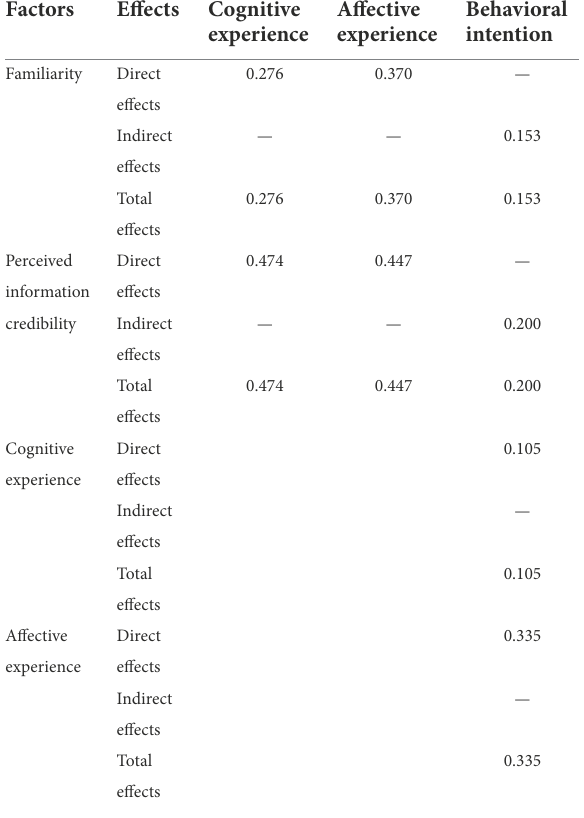
TABLE 7 Effects of